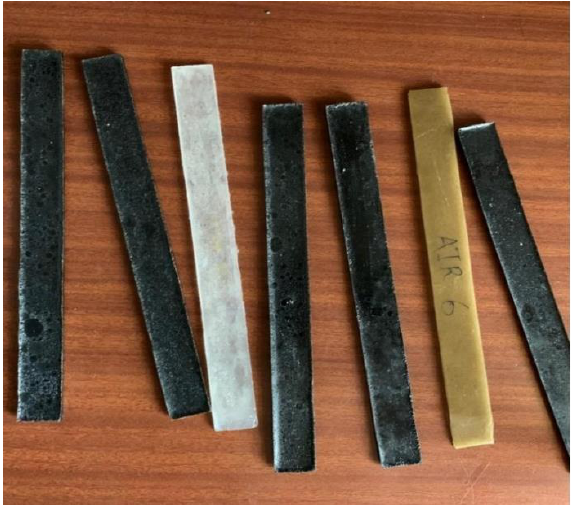
Figure 2. Specimens used for tensile test.